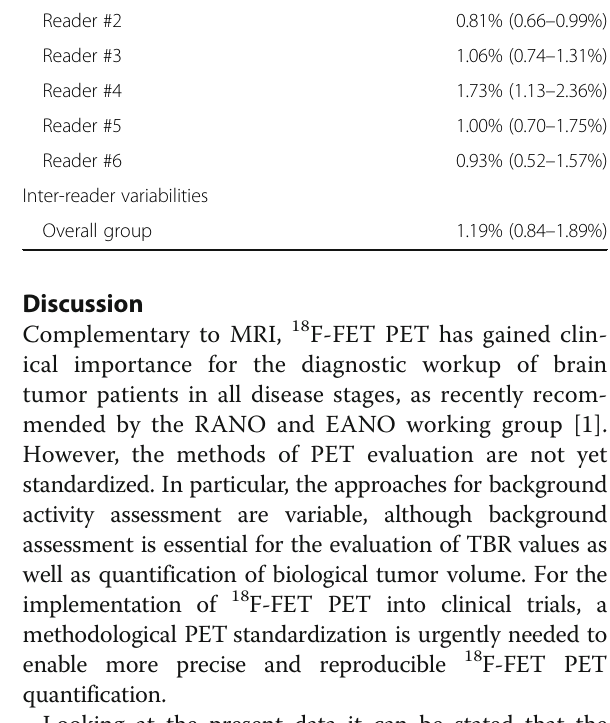
Table 2 Intra- and inter-reader coefficients of variation using the guided VOI [median (range)] Intra-reader variabilities Overall